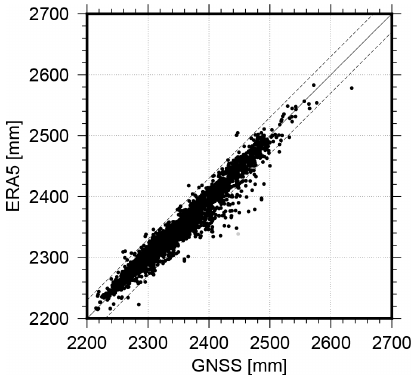
Figure 8. Comparison of ZTD values from shipborne GNSS and